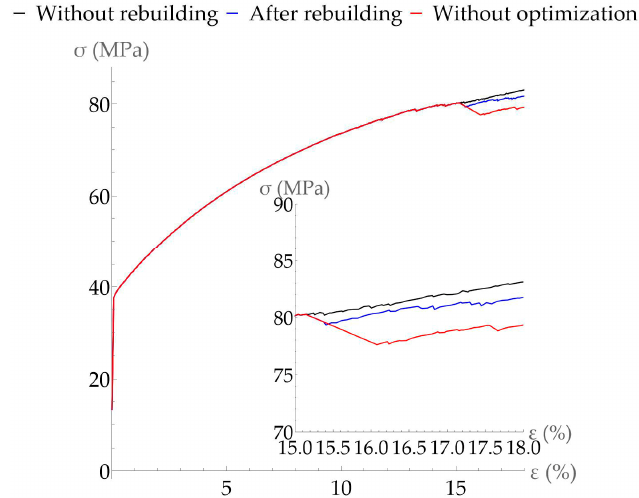
Figure 7. Stress versus accumulated strain curves for the representative volume element of a polycrystal without grain structure rearrangement (black), with optimization (blue), and without optimization (red). The grain structure is reconstructed at the deformation instant of 15%.